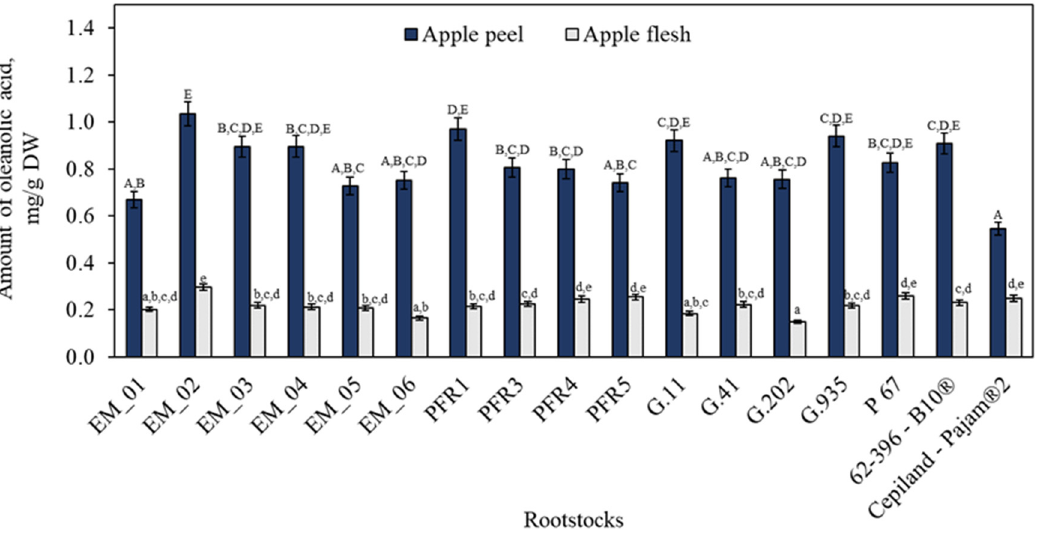
Figure 3. Influence of rootstocks on the quantitative composition of oleanolic acid. The means followed by different uppercase and lowercase letters are significantly different at p < 0.05.